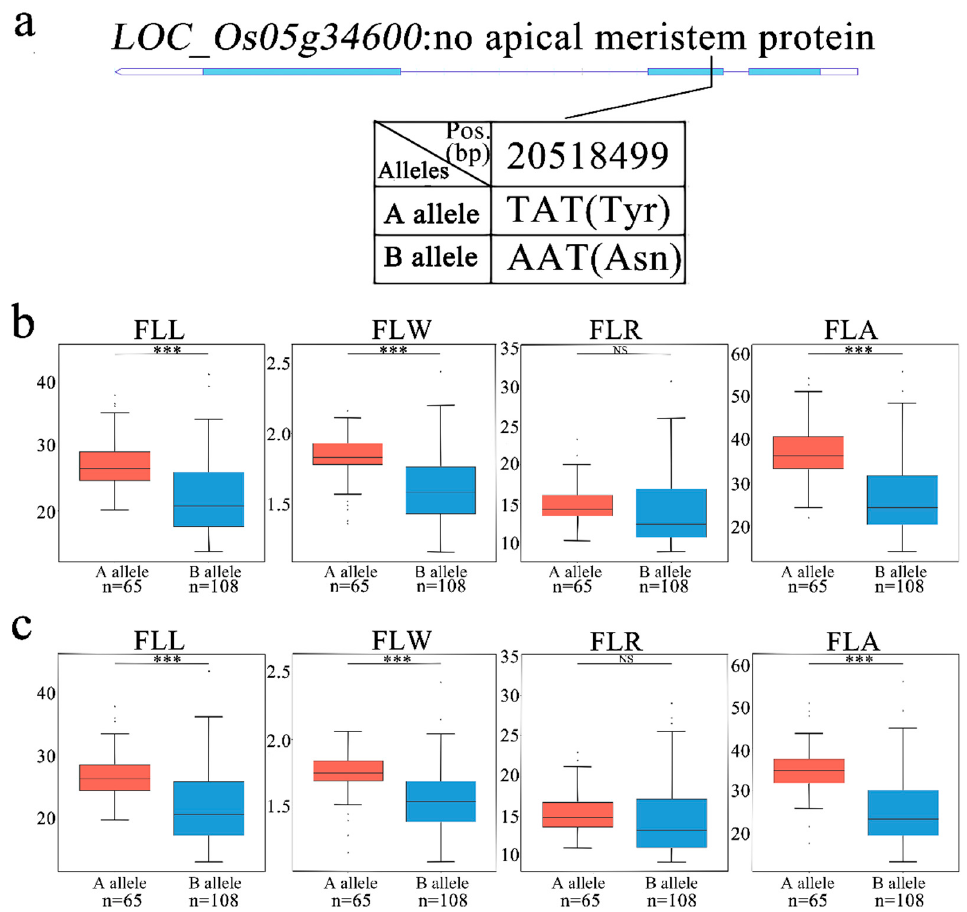
Figure 8. Haplotype analysis of the candidate gene LOC_Os05g34600 : ( a ) Schematic representation in LOC_Os05g34600 structure and single-nucleotide polymorphisms in LOC_Os05g34600 cDNA between the two alleles. Blue boxes indicate exons; ( b ) Box plots for FLL, FLW, FLR, and FLA in the four haplotypes of LOC_Os05g34600 in all accessions in 2019; ( c ) Box plots for FLL, FLW, FLR, and FLA in the four haplotypes of LOC_Os02g56760 in all accessions in 2020. The number of accessions (n) of each allele in each panel is given under the x -axis. Boxes show the median and upper/lower quartiles. Whiskers extend to 1.5× the inter-quartile range, with any remaining points indicated with dots. ***, p < 0.001; NS, not significant (Welch’s two-sample t -test).